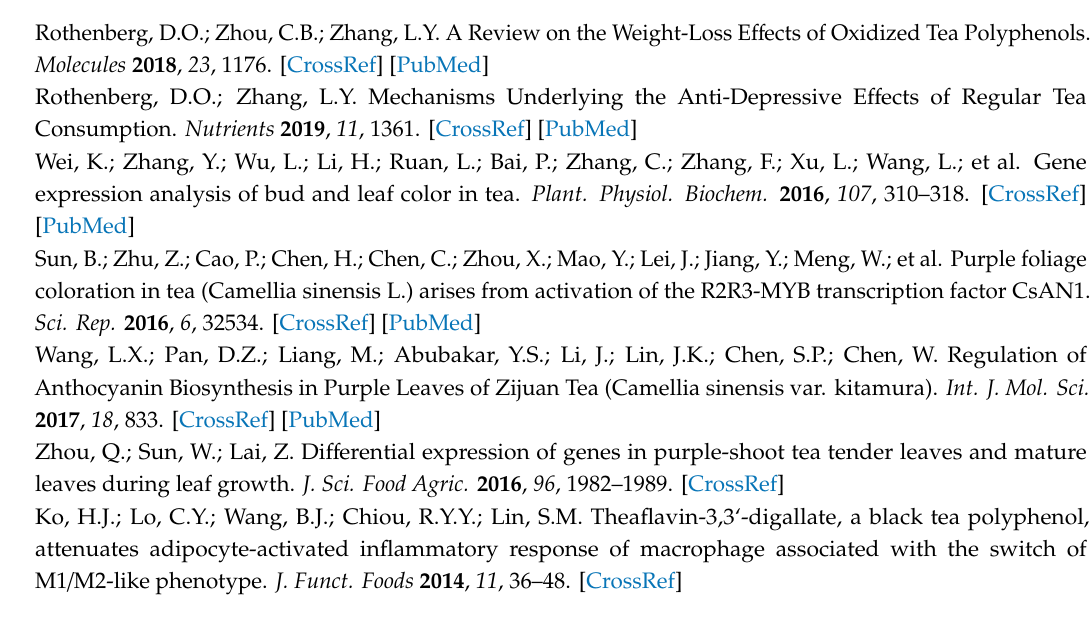
Supplementary Materials: Supplementary Materials are available online, Figure S1: DEMs statistics and Venn diagrams between white flower tea development stages, Table S1: Di ff erentially expressed metabolites (DEMs) during white tea flower (ZJW) and pink tea flower (BTP), Table S2: Overview of the transcriptome sequencing dataset and quality check, Table S3: Clean reads mapped to the reference genome in tea flower development, Table S4: DEGs statistics in di ff erent cDNA libraries during pink tea flower development, Table S5: Primer sequences for qRT-PCR analysis, Table S6: Hub genes from the brown and purple modules, Table S7: KEGG pathway enrichment analysis of DEGs in pink tea flowers, Table S8: Highly expressed structural genes involved in the flavonoid pathway in white and pink tea flower development stages, Table S9: DEGs in brown and purple module, Table S10: KEGG pathway enrichment analysis of DEGs in white tea